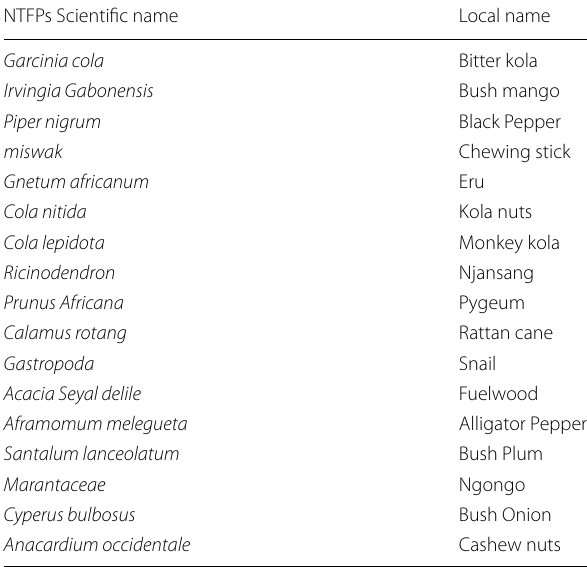
Table 2 Source: Fieldwork 2018